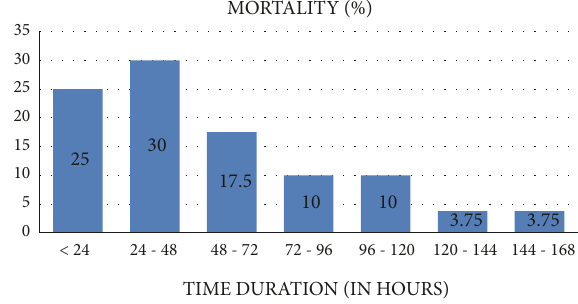
Figure 3: Mortality rate according to time